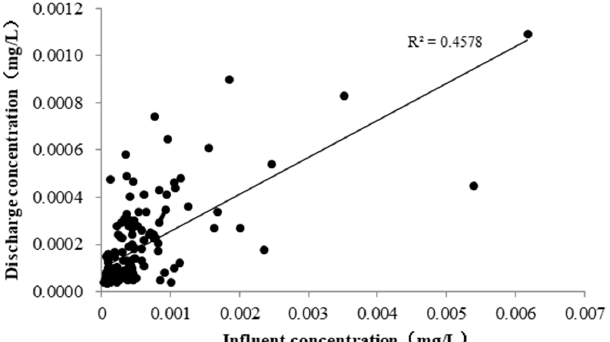
Figure 8. Relationship between the concentration of influent and effluent for Hg from WWTPs.